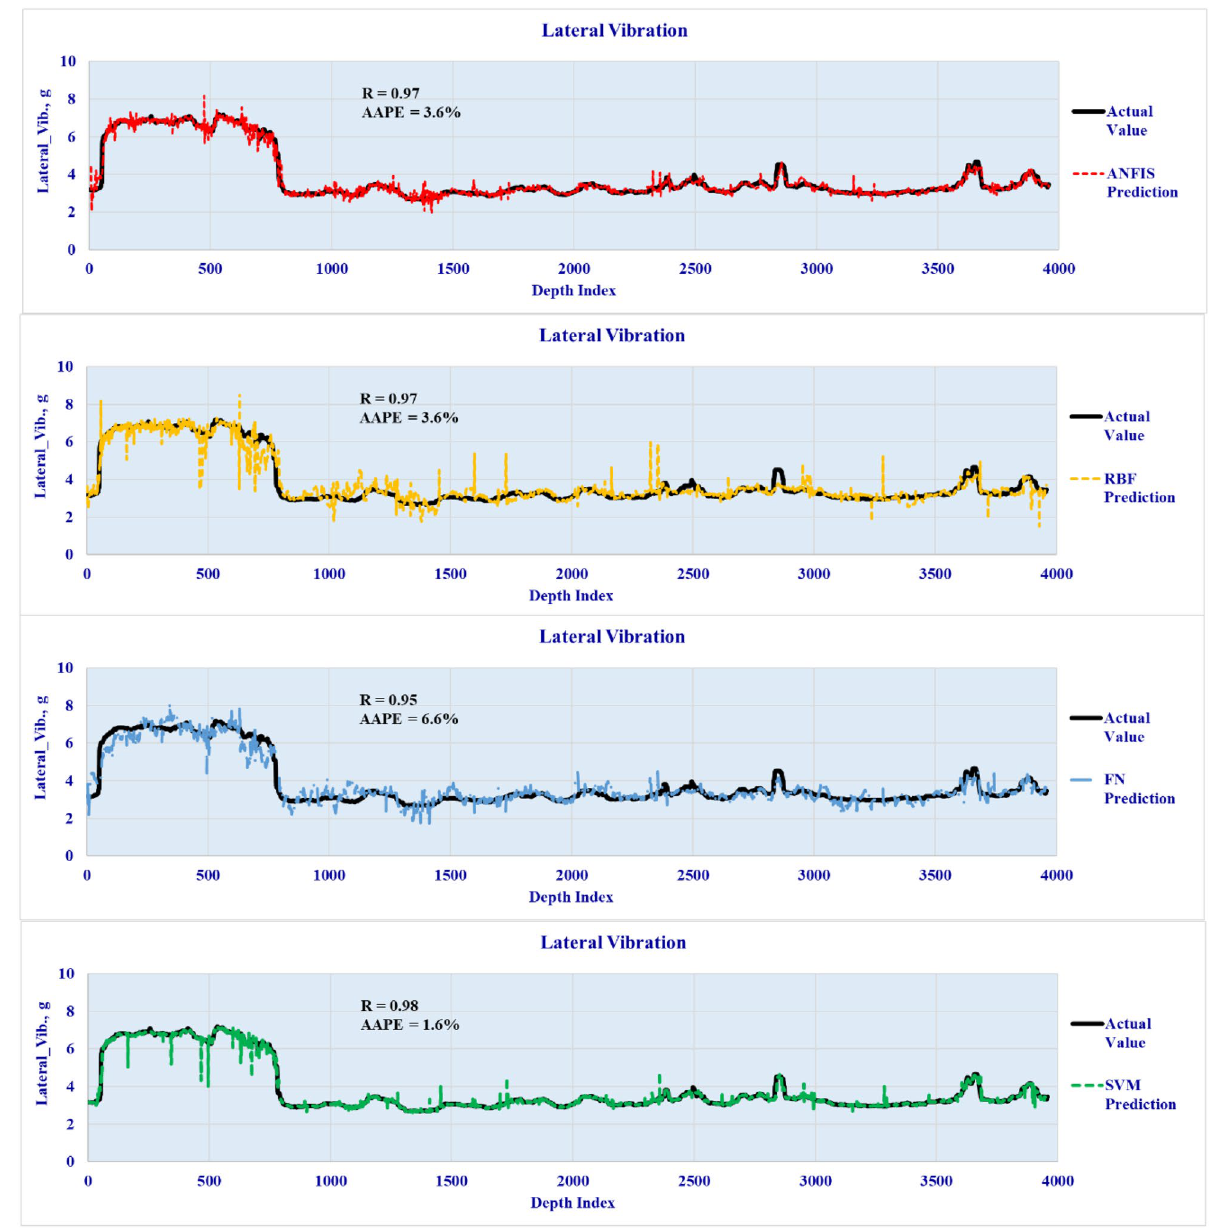
Figure 7. Lateral vibration prediction results (Validation well data